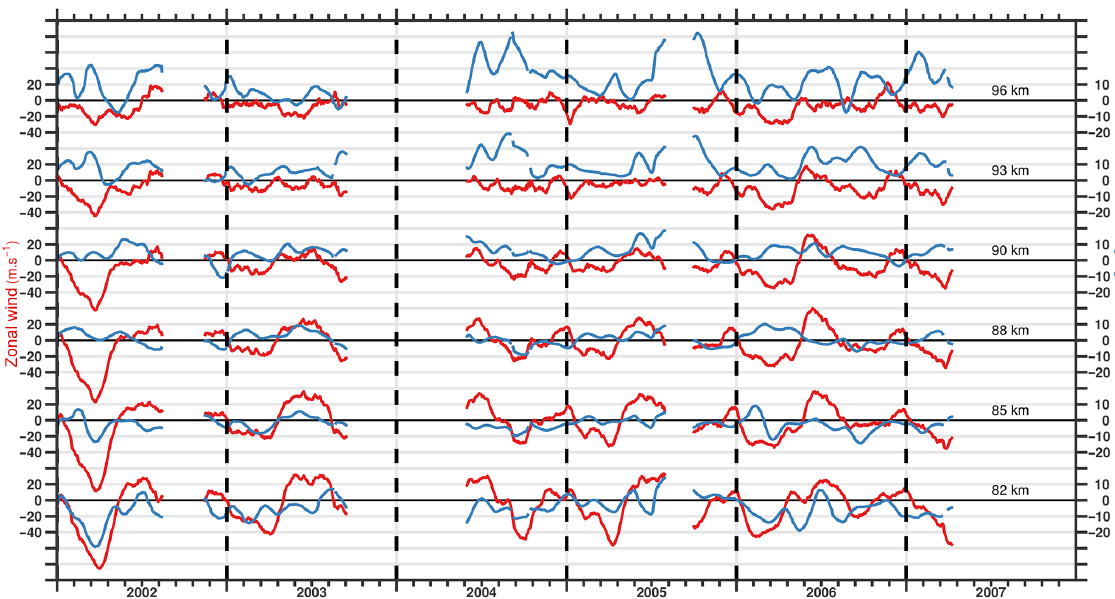
Figure 2. Monthly-mean zonal wind (red) and zonal momentum flux (blue) for 2002–2007 in six height gates. The horizontal black line is the 0ms − 1 (left y axis) and 0m 2 s − 2 (right y axis) line for each height gate. The average height is shown above the zero line for each height